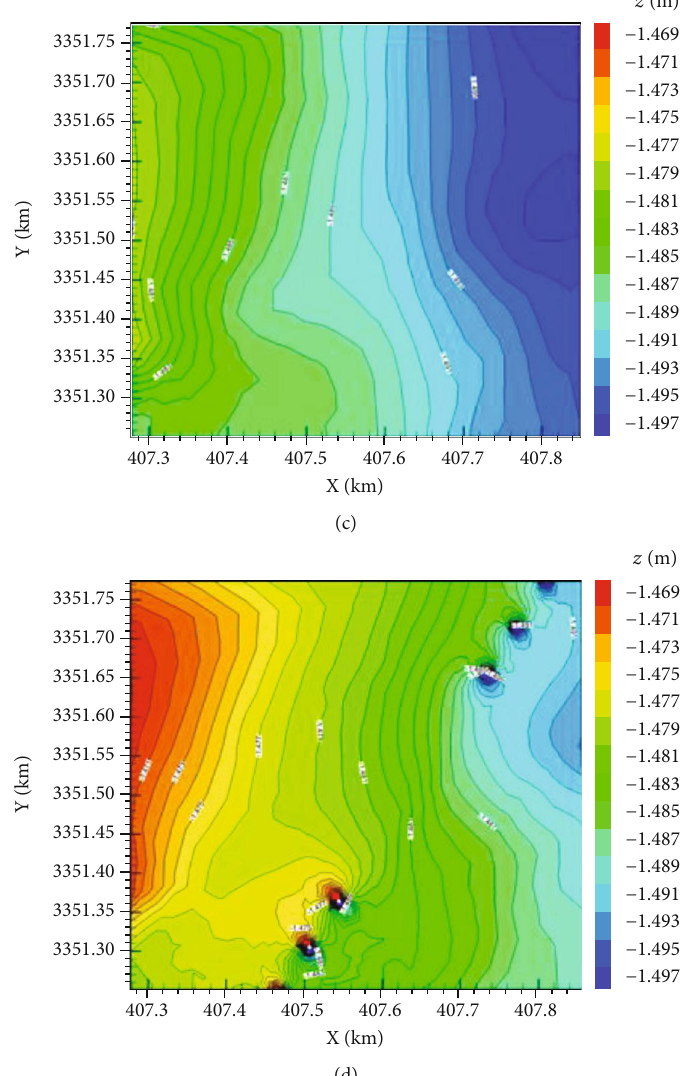
Figure 8: Comparison of the tidal level distribution before and after the construction of the project ( z indicates the water level). (a, b) Flood slack of spring tide. (c, d) Flood fall of spring